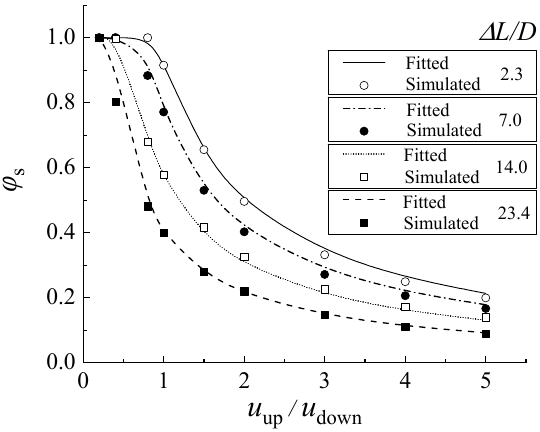
Figure 10. Comparison of calculated ϕ s with simulated results.